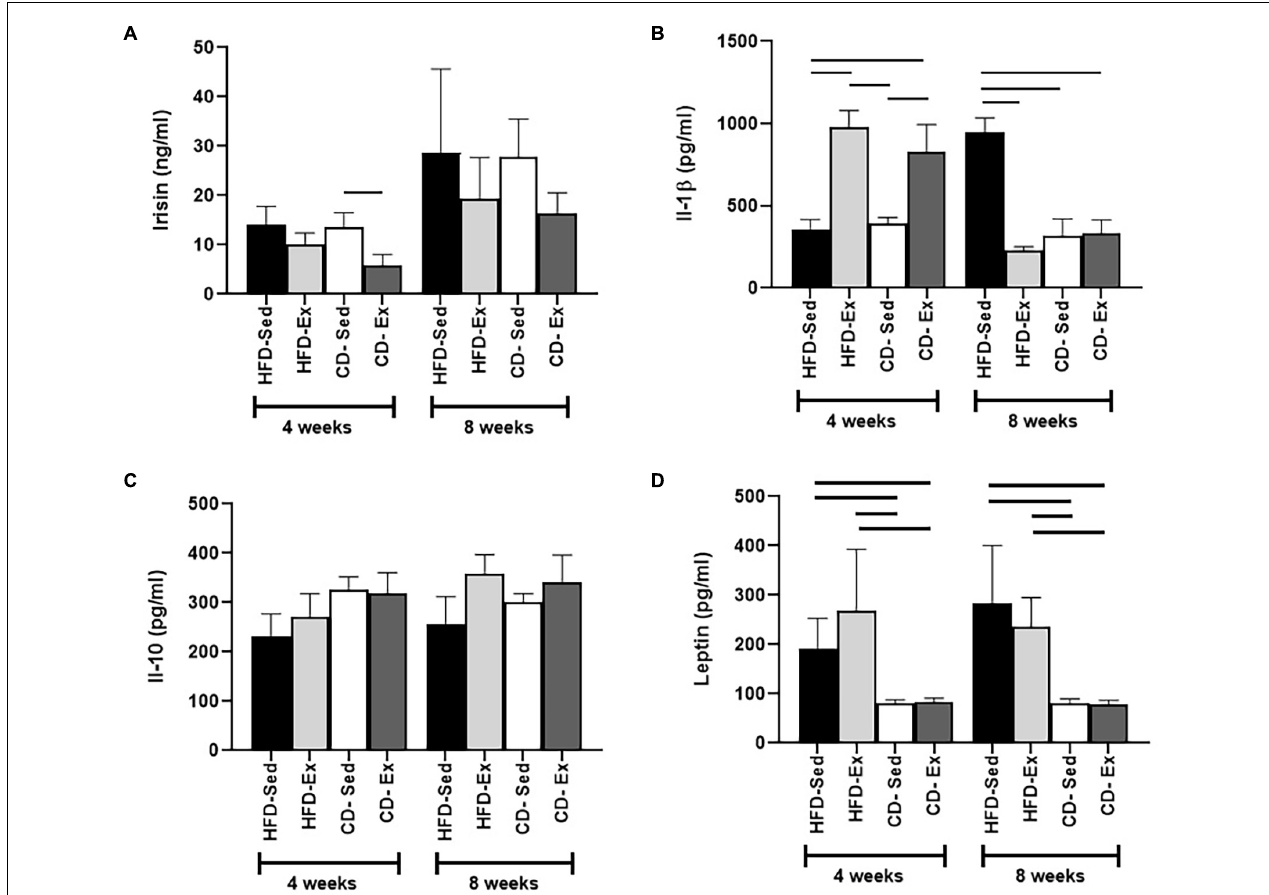
FIGURE 6 | Determination of serum levels of adipocytokines during the experiment. (A) Serum irisin concentration after 4 and 8 weeks of dietary and training interventions. (B) Interleukin 1-beta (IL-1 β ) was evaluated every 4 weeks. (C) Levels of interleukin 10 (IL-10) were determined after 4 and 8 weeks. (D) Serum leptin levels after 4 and 8